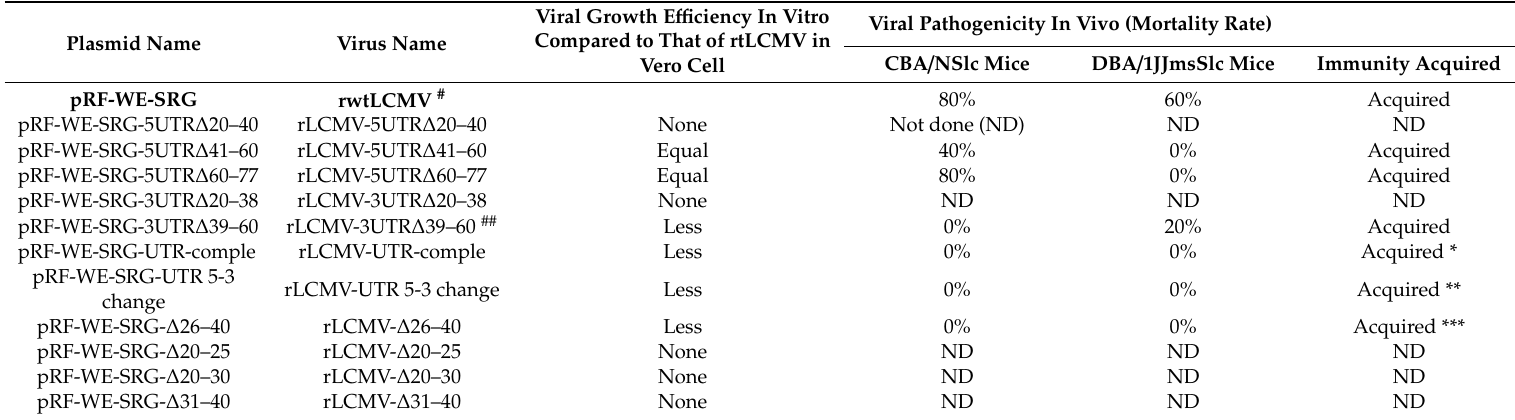
Table 4. Viral growth e ffi ciency in vitro and pathogenicity in vivo for recombinant LCMVs generated from each